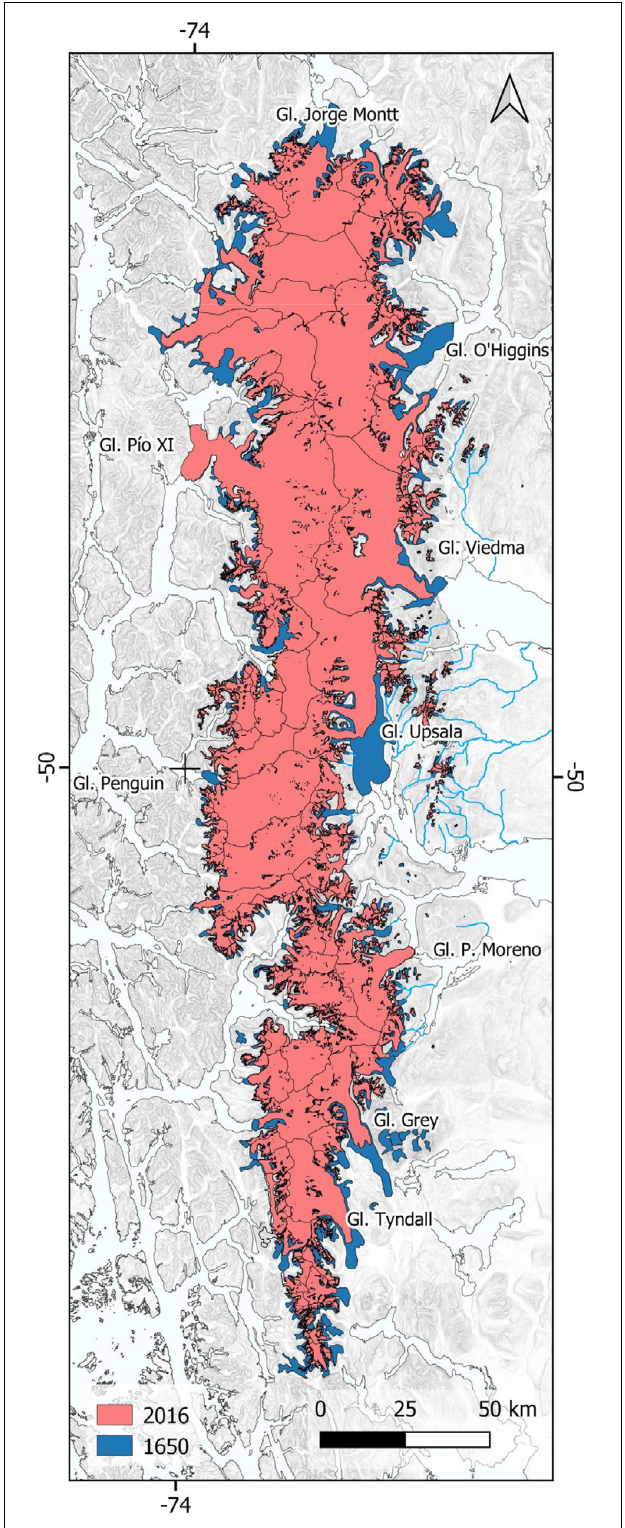
FIGURE 8 | Areal fluctuations of the SPI between the LIA and 2016 derived from reconstructions based on geomorphology and recent optical remote sensing data (Davies and Glasser, 2012; Meier et al.,